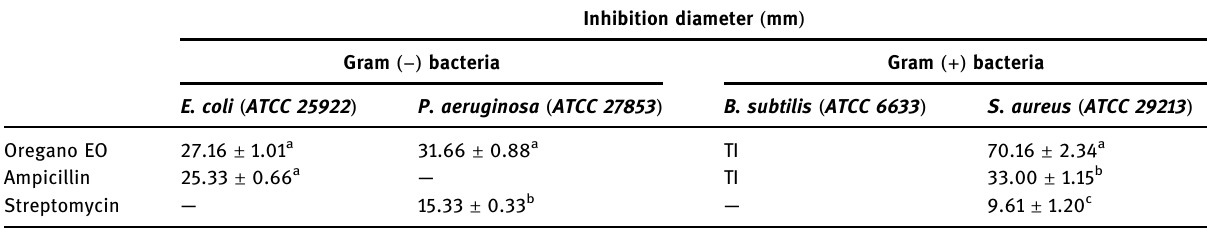
Table 4: Minimal inhibitory concentrations ( mg/mL ) of O. com - pactum EO against bacterial strains